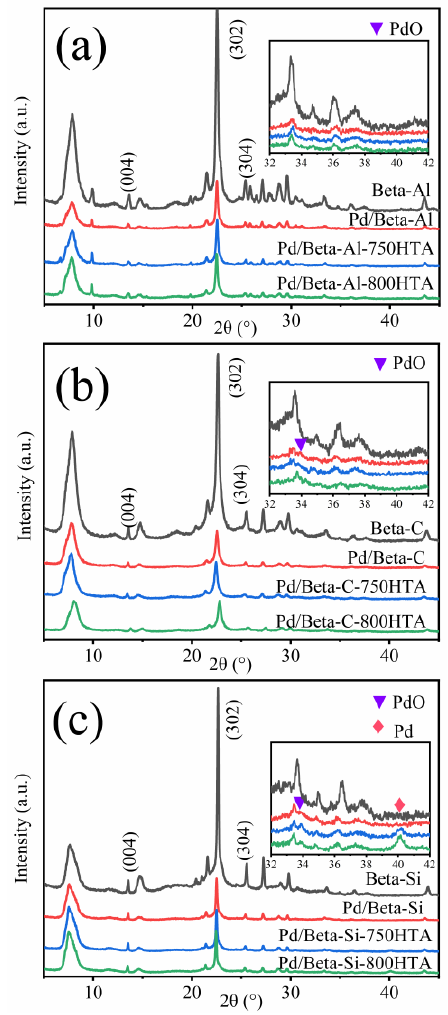
Figure 2. XRD patterns of ( a ) Beta-Al, Pd/Beta-Al, Pd/Beta-Al-750HTA and Pd/Beta-Al-800HTA; ( b ) Beta-C, Pd/Beta-C, Pd/Beta-C-750HTA and Pd/Beta-C-800HTA; and ( c ) Beta-Si, Pd/Beta-Si, Pd/Beta-Si-750HTA and Pd/Beta-Si-800HTA.